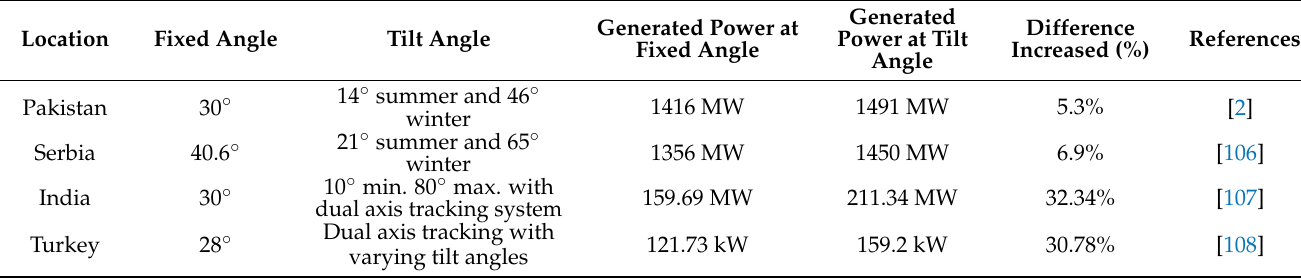
Table 6. Summary of the literature that concerns the effect of the tilt angle.